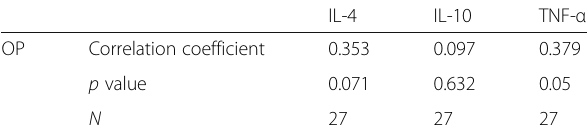
Table 4 Correlations of levels of cytokines to CSF opening pressure in IIH